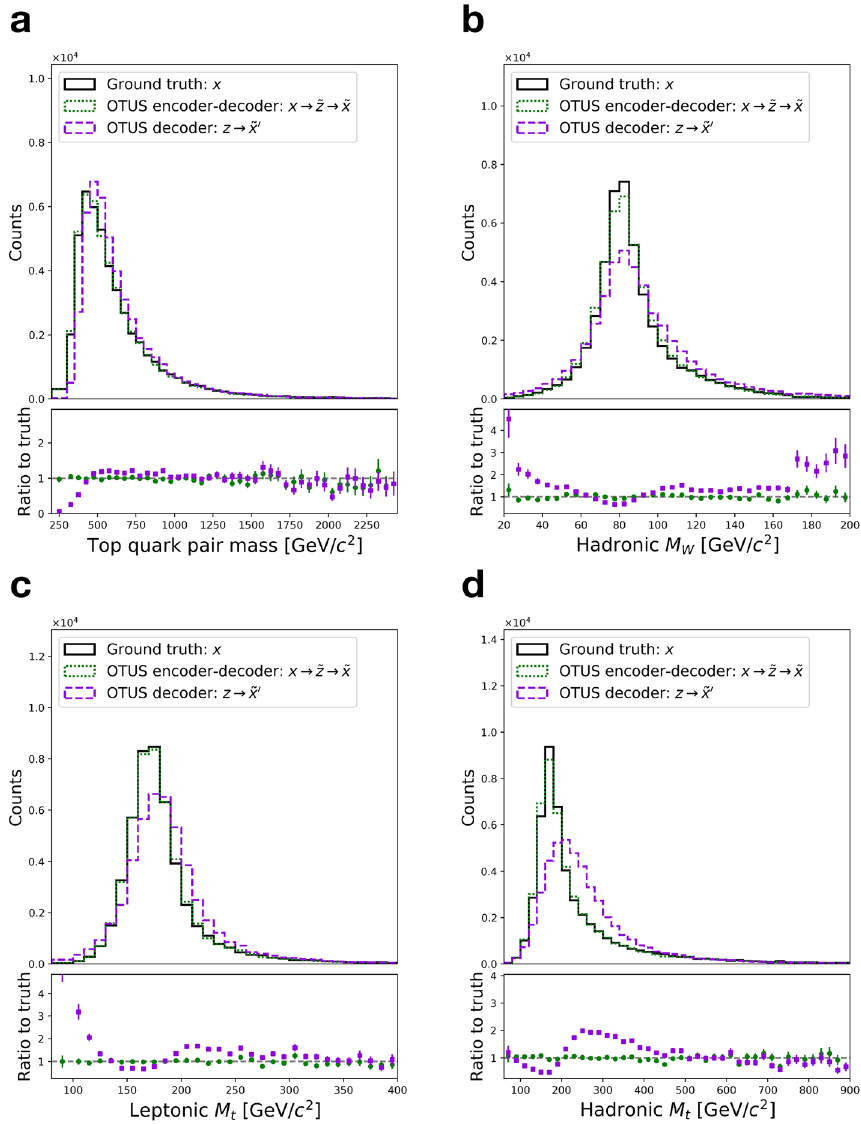
Figure 8. Performance of OTUS for semileptonic t ¯ t decays in physically important derived quantities in X . ( a ) Matching of the invariant mass of the combined t ¯ t pair. ( b ) Matching of the invariant mass of the hadronically decaying W -boson, M W . ( c ) Matching of the invariant mass of the top-quark, M t , reconstructed using information from the leptonically decaying W -boson. ( d ) Matching of the invariant mass of the top- quark, M t , reconstructed using information from the hadronically decaying W -boson. These show the testing sample { x ∼ p ( x ) } (solid black) in the experimental space, X , as well as output from the decoder applied to samples drawn from p ( z ), labeled as z → ˜ x ′ (dashed purple). Also shown are samples passed through both the decoder and encoder chain, x → ˜ z → ˜ x (dotted green). Dotted green and solid black distributions are matched explicitly during training. Enhanced differences between dashed purple and solid black indicate the encoder’s output needs improvement, as p E ( z ) does not fully match p ( z ). Residual plots show bin-by-bin ratios with statistical uncertainties propagated accordingly (see